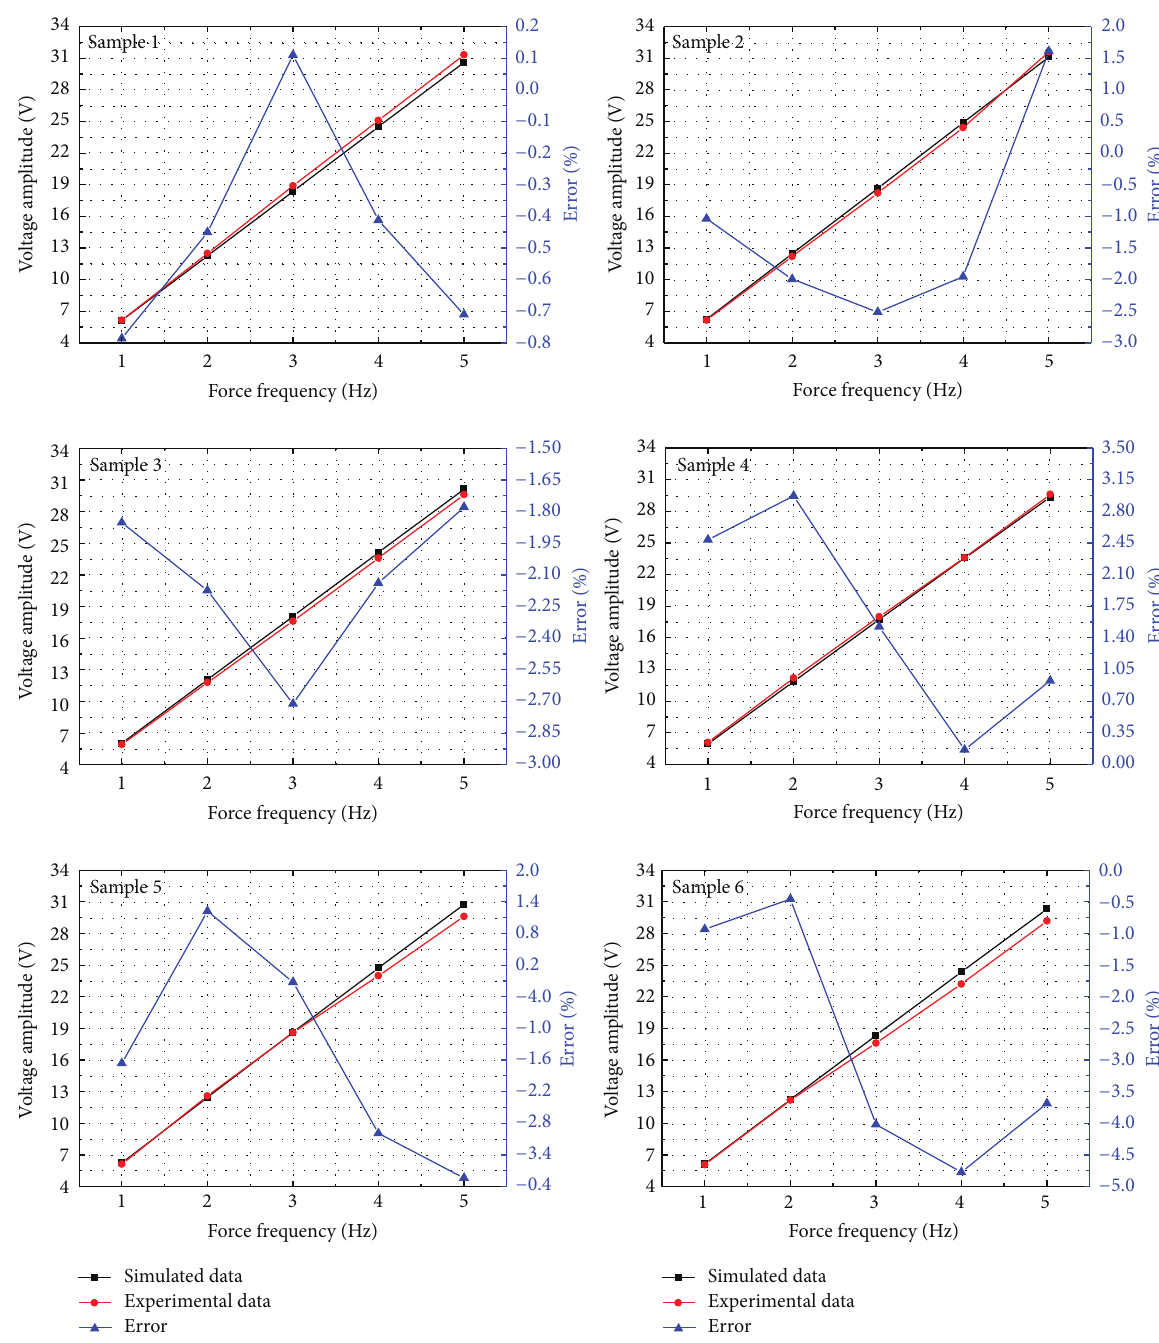
Figure 11: Experimental and simulated results of the output voltage amplitude of samples 1 ∼ 6.